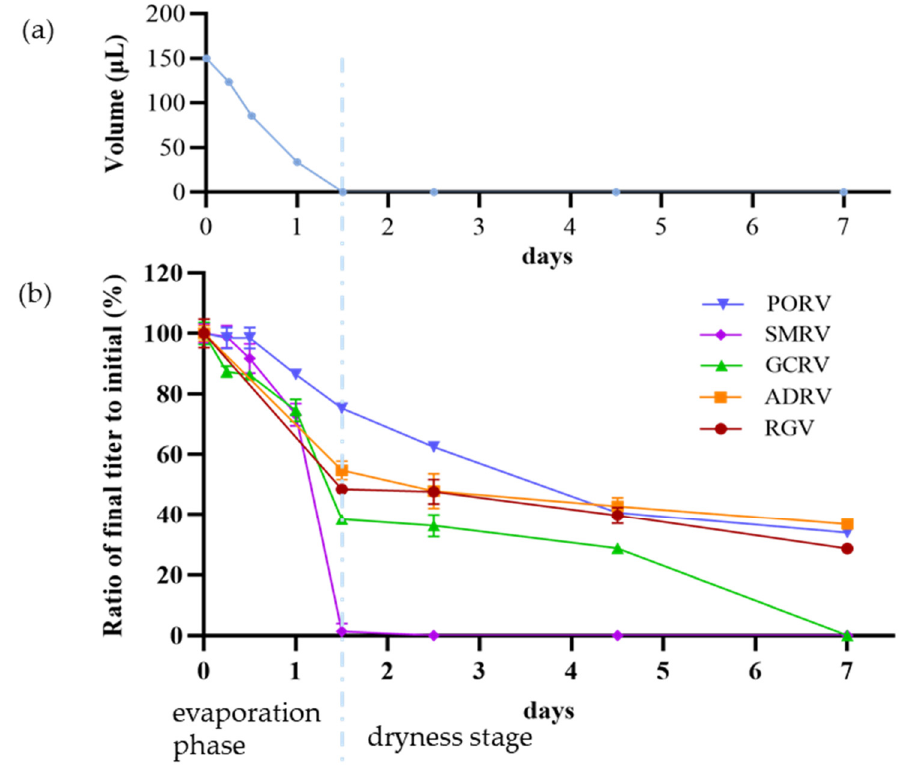
Figure 4. Drying process and effects of drying stress on titers of five aquatic animal viruses. ( a ) Drying process was divided into two phases: an evaporation phase (0~1.5 d, the front part) during which the volumes of virus suspensions decreased from 150 μ L to 0 μ L, and a dryness stage (1.5~7d, the latter part), in which the virus suspensions have completely dried. ( b ) The decrease in virus titers in drying process. Each point showed the ratio of the titer after treatment to initial titer for each virus.